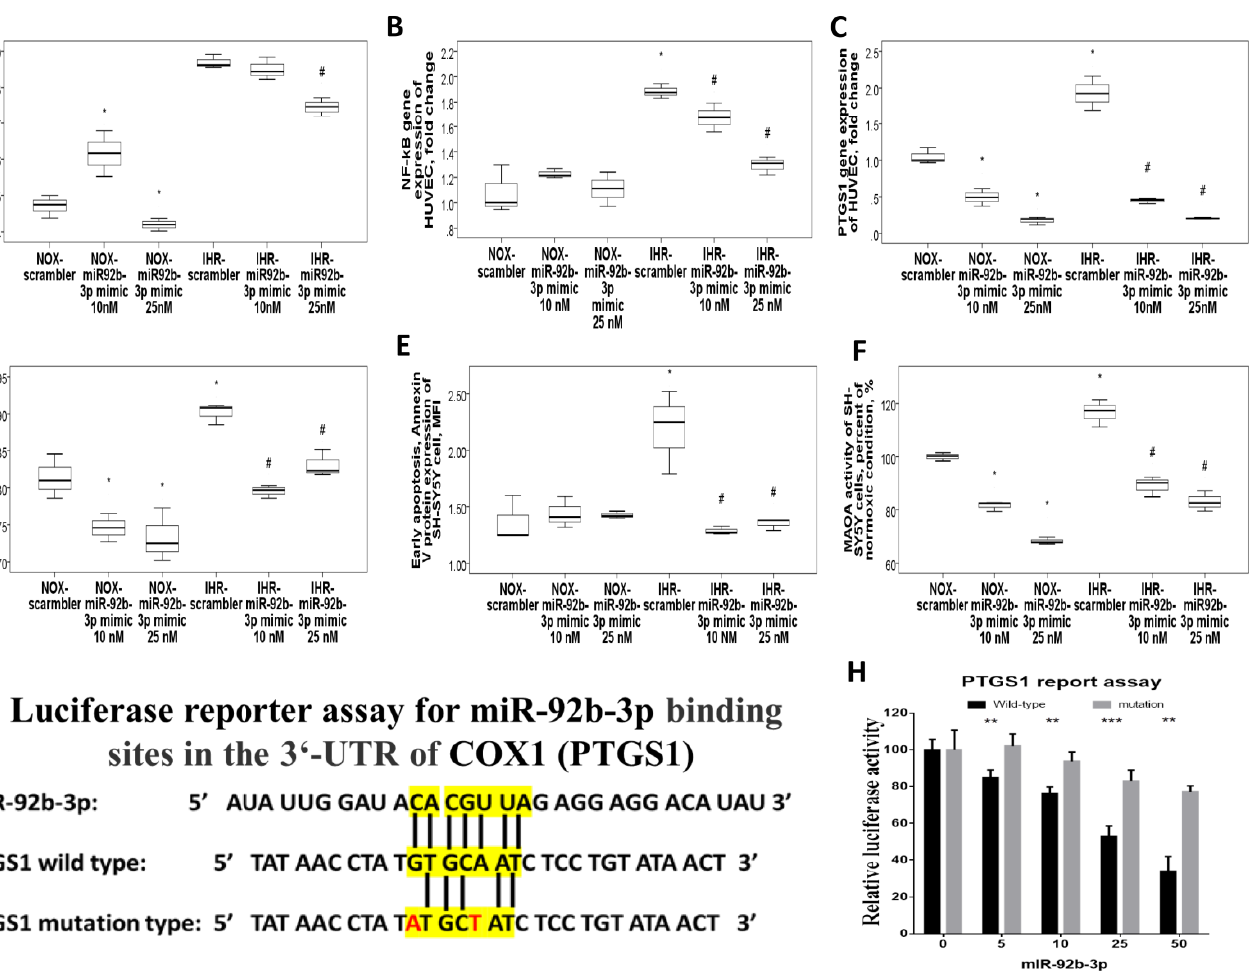
Figure 7. MiR-92b-3p over-expression reversed intermittent hypoxia with re-oxygenation (IHR)-induced apoptosis, monoamine oxidase (MAO)-A hyperactivity, and up-regulation of its target mRNAs through directly targeting PTGS1. Transfection with a miR-92b-3p mimic in THP-1 cells reversed IHR-induced ( A ) early apoptosis. Transfection with miR-92b-3p in HUVEC reversed IHR-induced up-regulation of its target genes, including ( B ) NF- κB 1 , and ( C ) PTGS1 . Transfection with miR-92b-3p in SH-SY5Y cells reversed IHR-induced ( D ) ROS production, ( E ) early apoptosis, and ( F ) MAOA hyperactivity. ( G ) The wild-type sequence and mutated sequence of putative miR-92b-3p binding sites in the 3′ untranslated region of PTGS1 are shown. ( H ) The direct binding between miR-92b-3p and PTGS1 was confirmed using luciferase reporter gene assays. * p < 0.05, compared with normoxic (NOX) condition. ** p < 0.01, compared with normoxic (NOX) condition. *** p < 0.001, compared with NOX condition. # p < 0.05, compared with IHR condition.